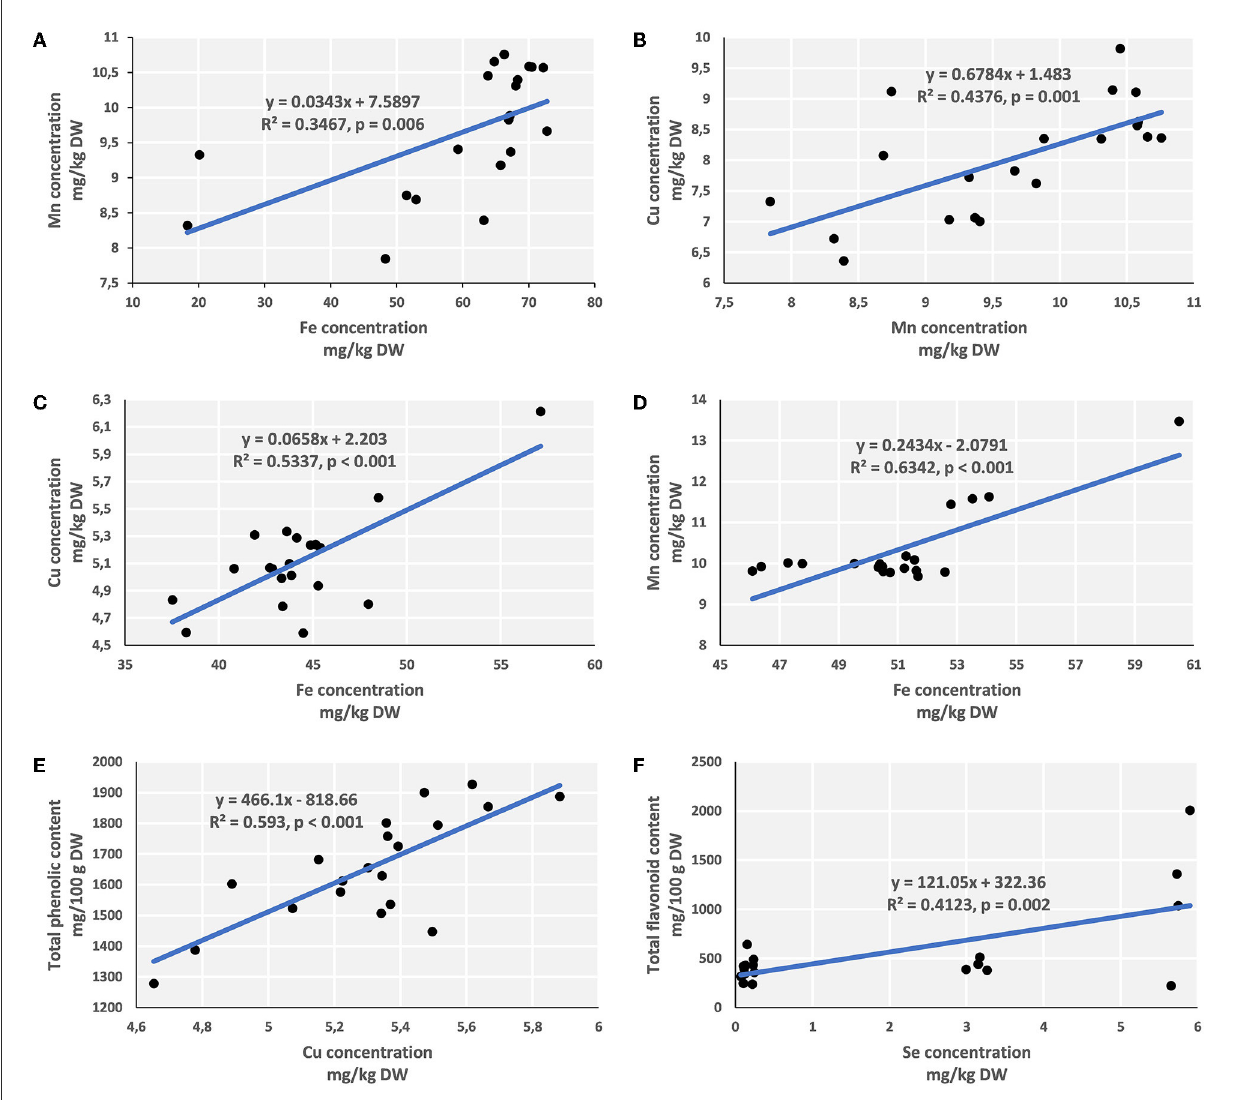
FIGURE2 Bivariate correlations between Mn and Fe concentrations for Ambassador from the 2015 growing season (A) , between Cu and Mn concentrations for Ambassador from the 2015 growing season (B) , between Cu and Fe concentrations for Premium from the 2014 growing season (C) , between Mn and Fe concentrations for Premium from the 2015 growing season (D) , between total phenolics and Cu concentration for Premium from the 2015 growing season (E) , and between total flavonoids and Se concentration for Premium from the 2015 growing season (F)